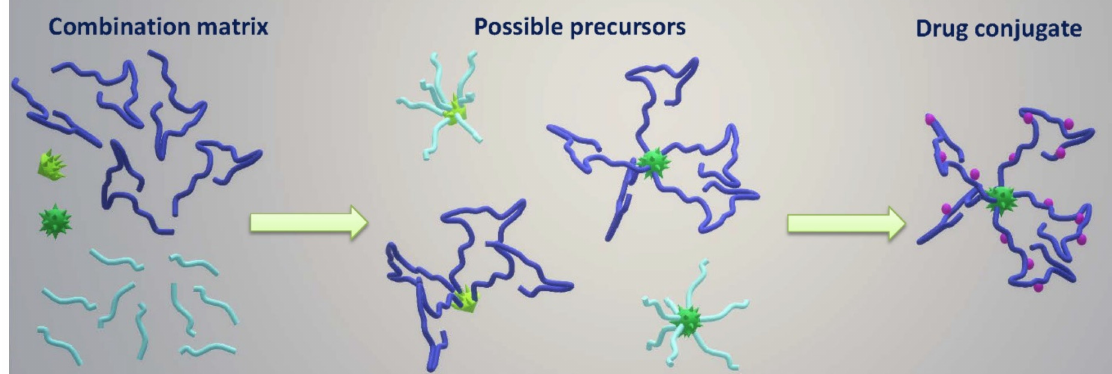
Figure 4. Schematic sketch of the formation of adjustable star-shaped nanomedicine based on semitelechelic pHPMAs and polyester-based core. Green stars are bisMPA cores, light and dark blue lines are polymers, violet dots represent